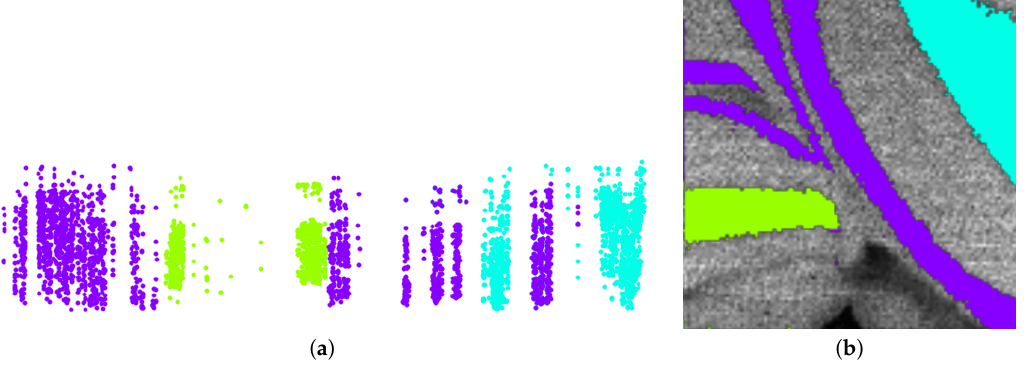
Figure 5. Non-linear embedding of sub-population with horizontal axis being replaced by space-filling curve ( a ) allows for separation of continuous image regions even in rather nested cases. ( b ) Methodology applied to mouse cerebellum in negative ion mode data set